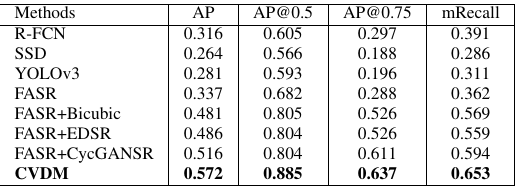
Table 9. Results on UCAS-AOD